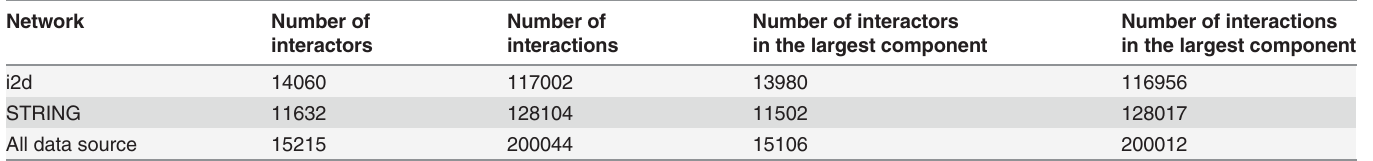
Table 1. Networks used in this work.